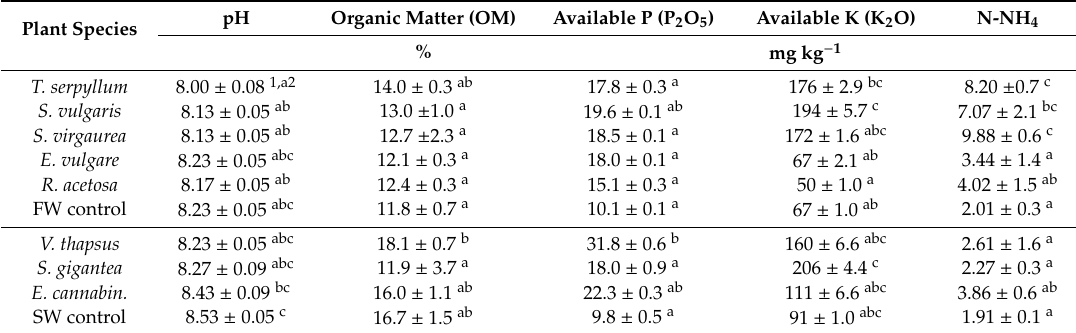
Table 1. Average chemical characteristics of the flotation waste (FW) and slag waste (SW) soils. pH Organic Matter (OM) Available P (P 2 O 5 ) Available K (K 2 Plant Species